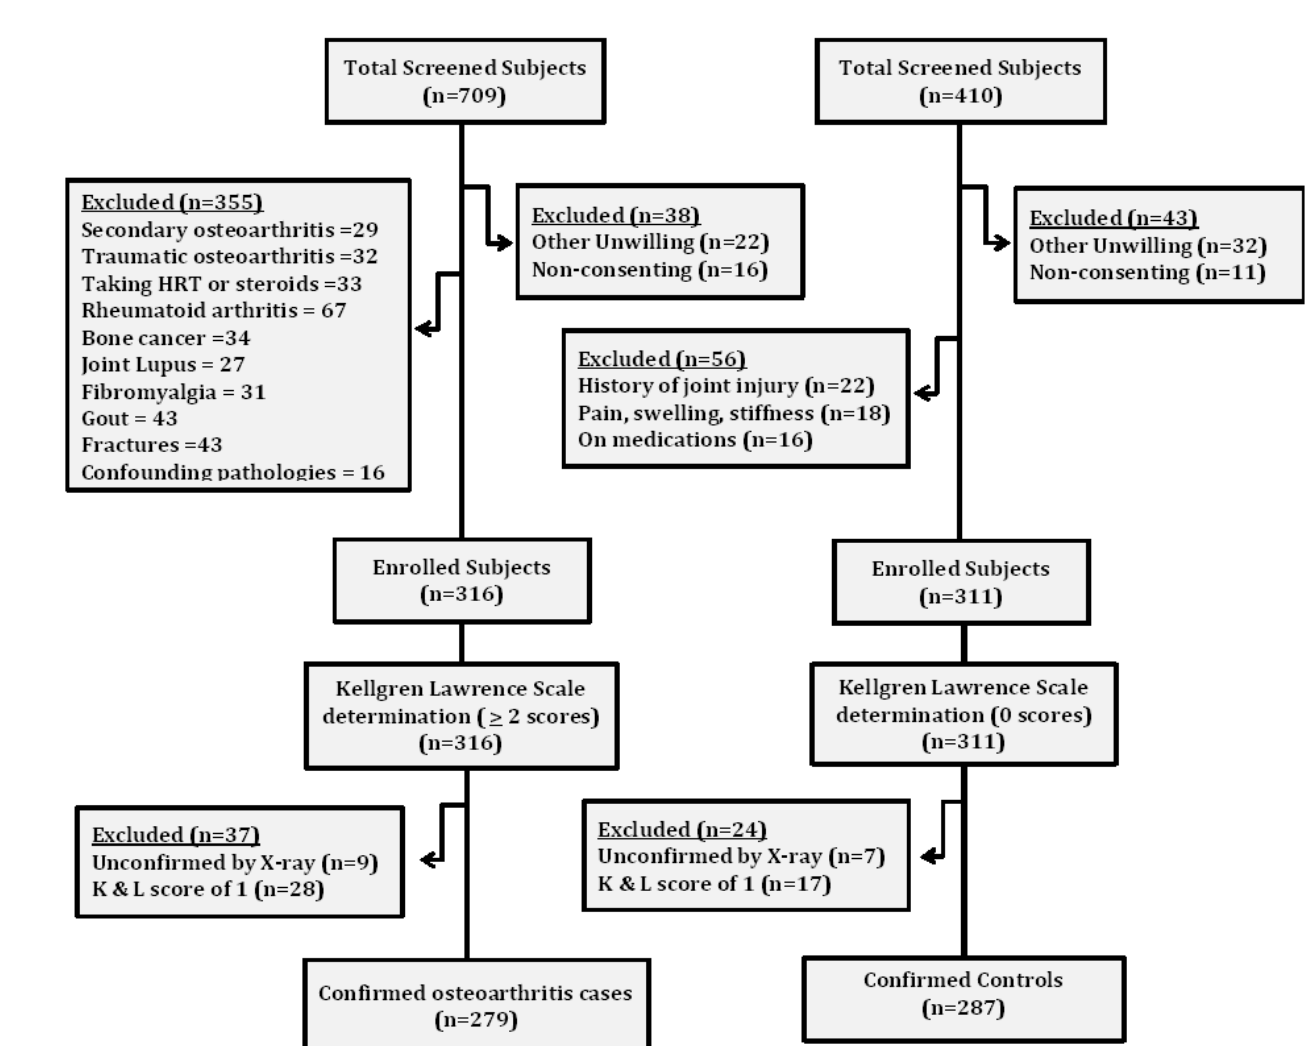
Figure 1. Flow chart showing the data collection protocol.